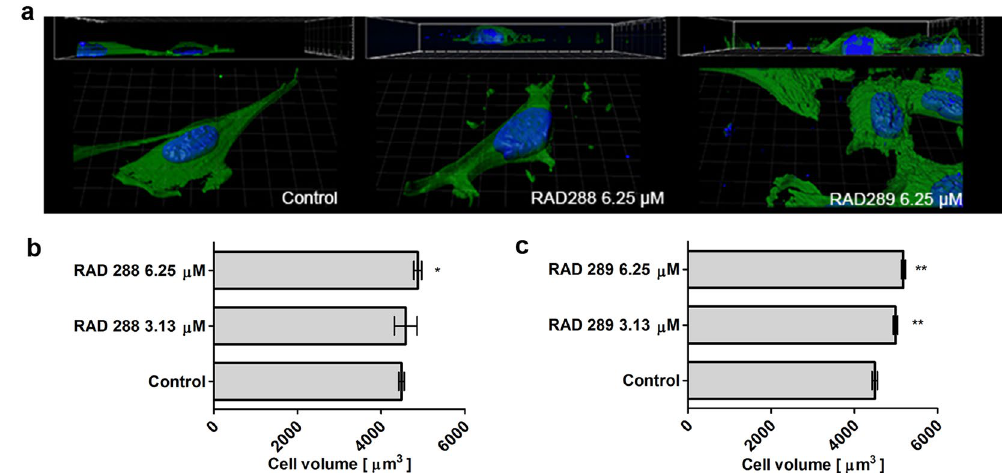
Figure 5. Analysis of mOEC cytoplasmic volume after treatment with RAD288 and RAD289. ( a ) Representative images of mOECs after drug exposure generated by confocal microscopy and Imaris software. ( b ) Cytoplasmic volume of mOECs after treatment with RAD288 at 3.13 and 6.25 µ M. ( c ) Cytoplasmic volume of mOECs after treatment with RAD289 at 3.13 and 6.25 µ M. Triplicate wells were used in three separate experiments, mean ± SEM. ** p < 0.01, * p < 0.05, Student’s